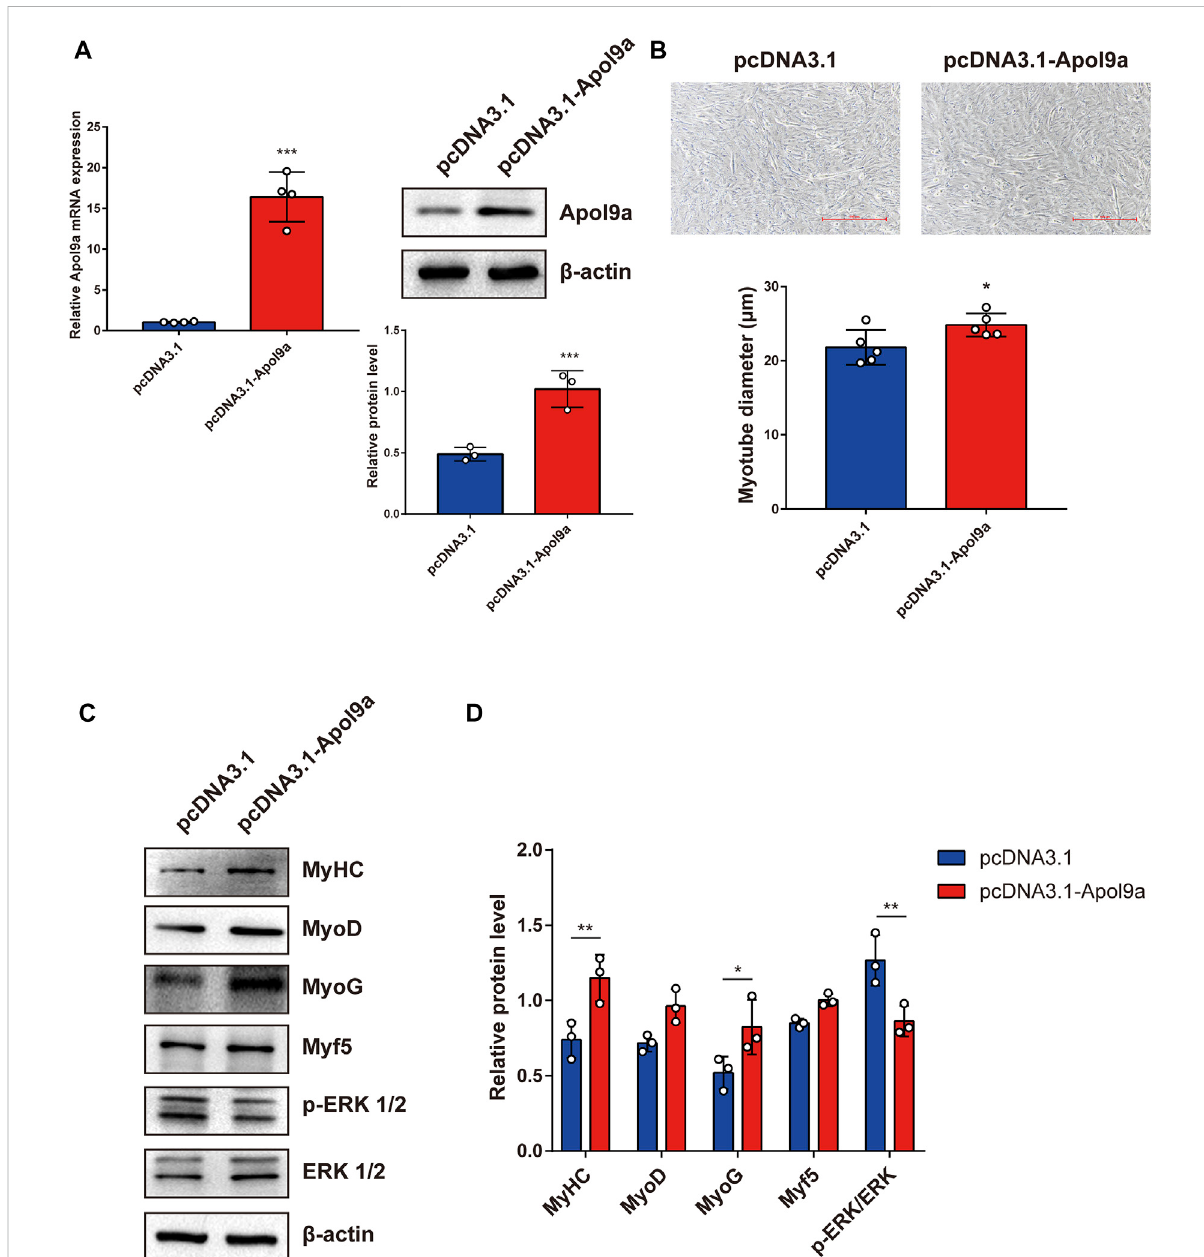
FIGURE 4 Apol9a overexpression promotes myogenic differentiation. C2C12 cells were induced to differentiate after pcDNA3.1 or pcDNA3.1- Apol9a transfectionfor4 days. (A) qPCRandwesternblotvalidationoftheef fi ciencyof Apol9a overexpressioninC2C12cells. (B) MorphologyofC2C12cells treatedwithpcDNA3.1orpcDNA3.1- Apol9a .Theresultsofquanti fi cationofaveragemyotubediameterareshownintheright. (C) Proteinexpression levels of MyHC, MyoD, Myf5, MyoG, p-ERK 1/2, ERK 1/2, and β -actin were estimated through western blot analysis after transfection. (D) Gray scale analysis of western blot results of (C) determined using ImageJ software. The data are expressed as mean ± SEM from at least